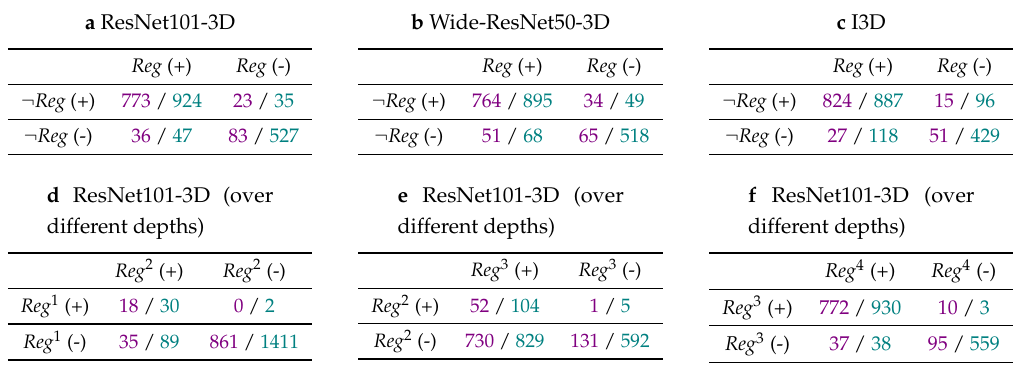
Table 4. McNemar’s statistical significance test on the first split of UCF-101 and HMDB-51. Results with and without regularization for ( a ) ResNet101, ( b ) Wide-ResNet, and ( c ) I3D models. ( d – f ) present results for class-regularized ResNet101 across different blocks in the architecture.